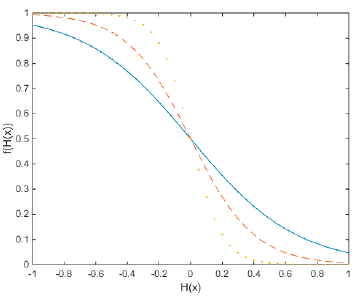
Figure 3. The characteristic curve of the penalty function.